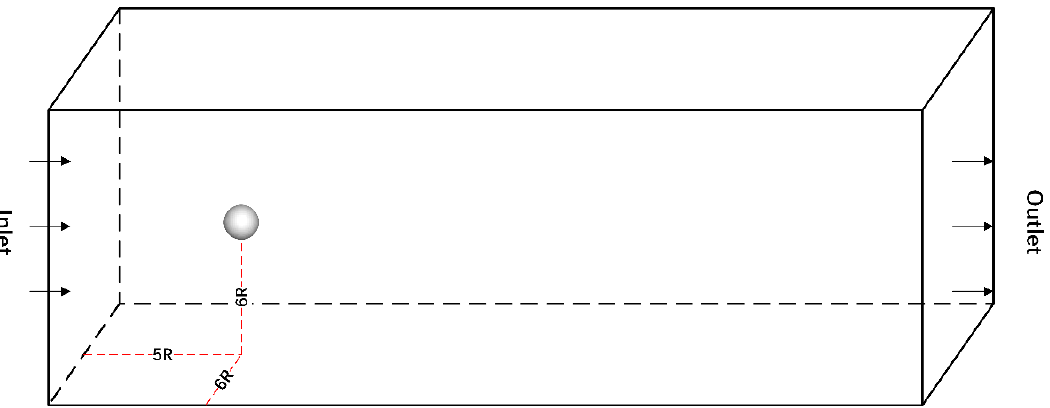
Figure 18. Geometry diagram shows the coordinate system and computational domain of the sphere around the flow in three dimensions.